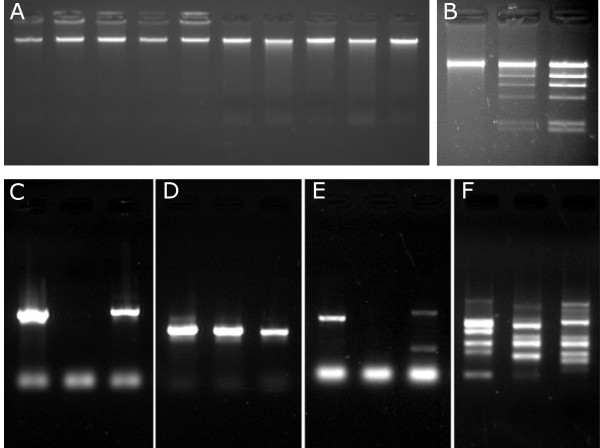
Features and properties of enzymatically isolated DNA. A: comparison of the amount of DNA isolated from Ilex aquifolium leaves by a conventional extraction method (lines 1–5) and by the enzymatic method described here (lines 6–10). In both case the amount of loaded DNA is one fifth of the DNA corresponding to one leaf disk. B: Study of the stability of lambda DNA/Hind III during the digestion of leaf disks of Ilex. Line 1: one leaf disk alone; line 2: one leaf disk and lambda DNA/Hind III; line 3: lambda DNA/Hind III alone. C, D, E, and F: PCR amplification of enzymatically isolated DNA from Ilex aquifolium (line 1), Aster amellus (line 2), and Solanum tuberosum (line 3). C: PCR amplification of the plastid atpB-rbcL spacer. D: PCR amplification of ITS/5.8S. E: PCR amplification of the nuclear encoded plastid glutamine synthetase. F: RAPD amplification.